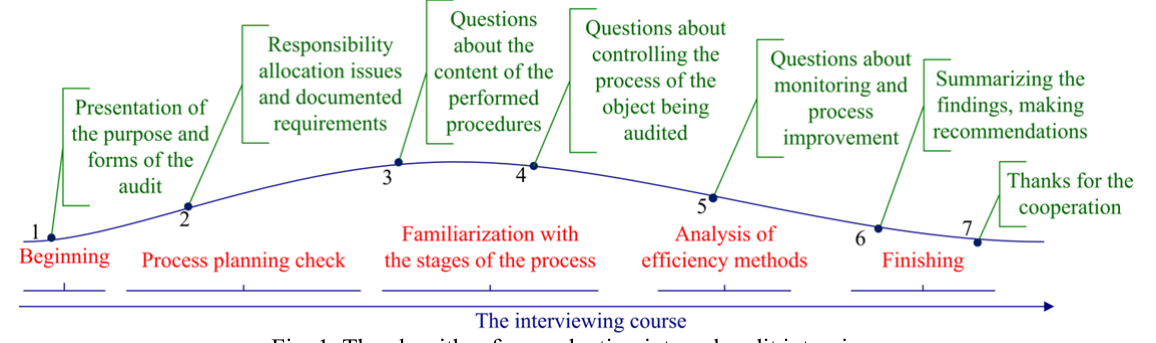
Fig. 1. The algorithm for conducting internal audit